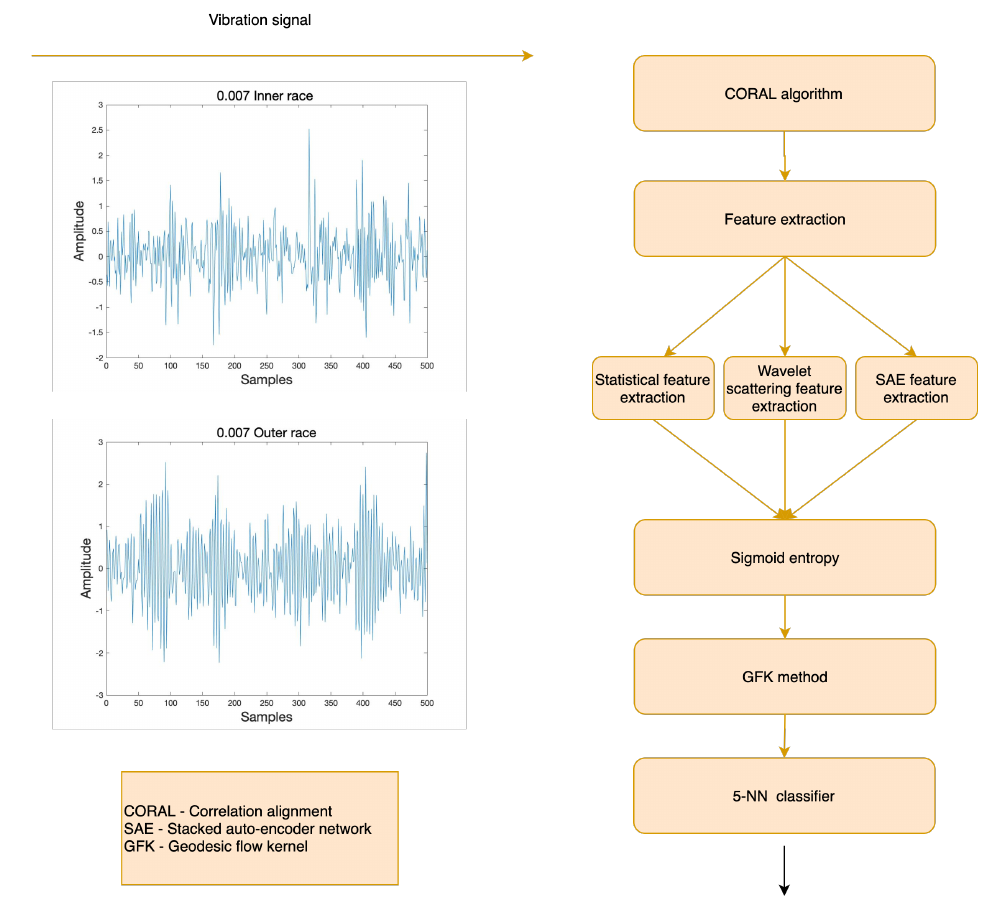
Figure 1. The flowchart of the proposed fault diagnosis